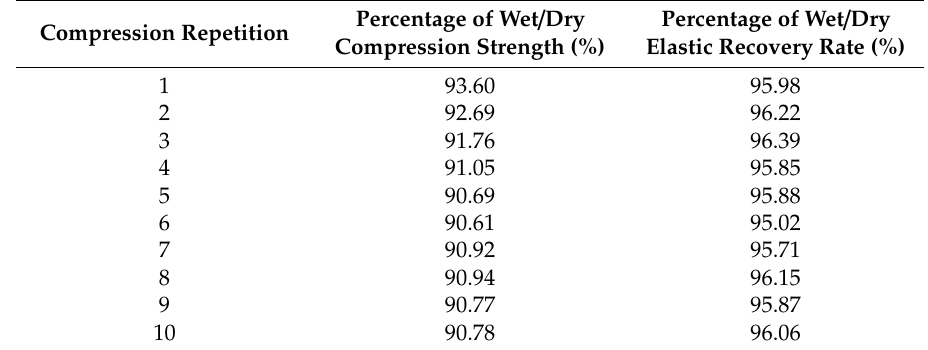
Table 4. Percentage of wet / dry compression strength and elastic recovery rate under di ff erent compression repetitions.